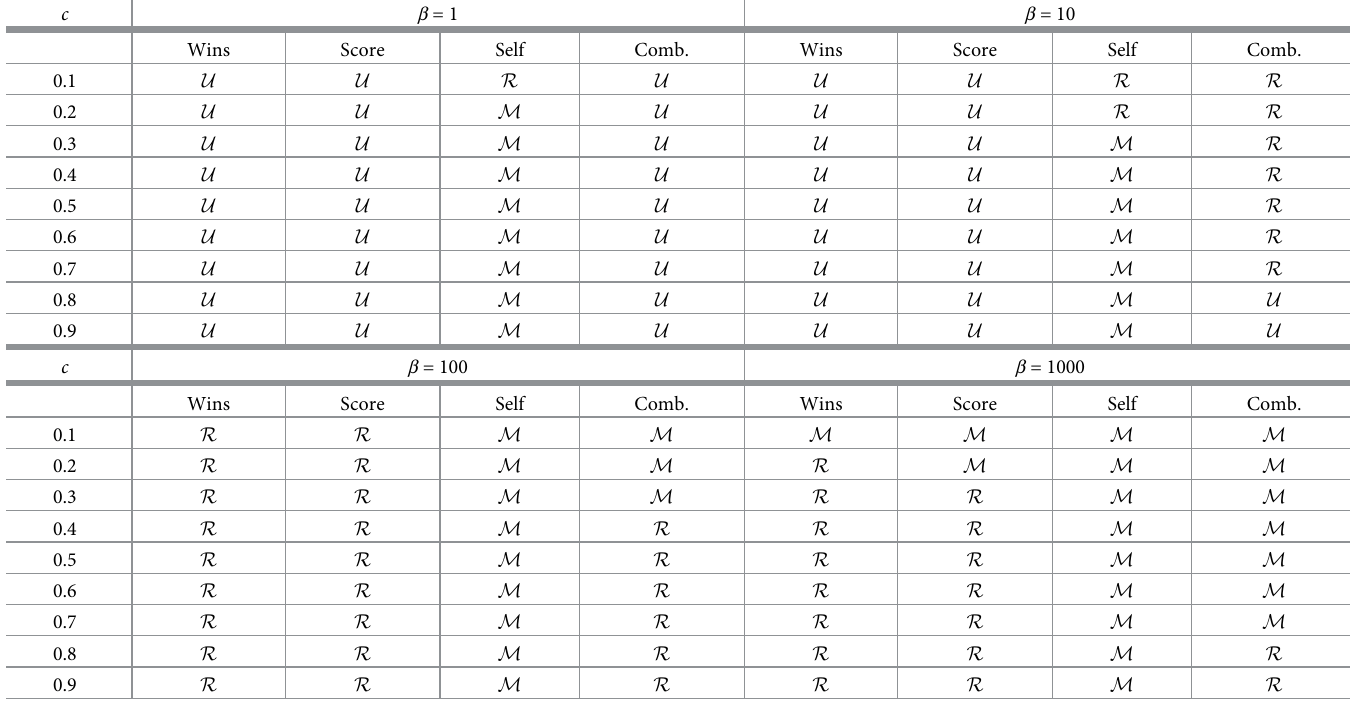
Table 4. Tournament winners for different rankings and selection strengths. We summarize our static results by showing the tournament’s winner for various costs and selection strengths, with respect to the four different rankings ( i ) number of wins, ( ii ) score, ( iii ) self payoff, and ( iv ) combined score. Memory-1 strategies typically obtain the highest self-payoff. However, they only succeed in the other rankings when cooperation is cheap (small c ) and when selection is sufficiently strong (large β ). c β = 1 β = 10 Wins Score Self Comb. Score Self